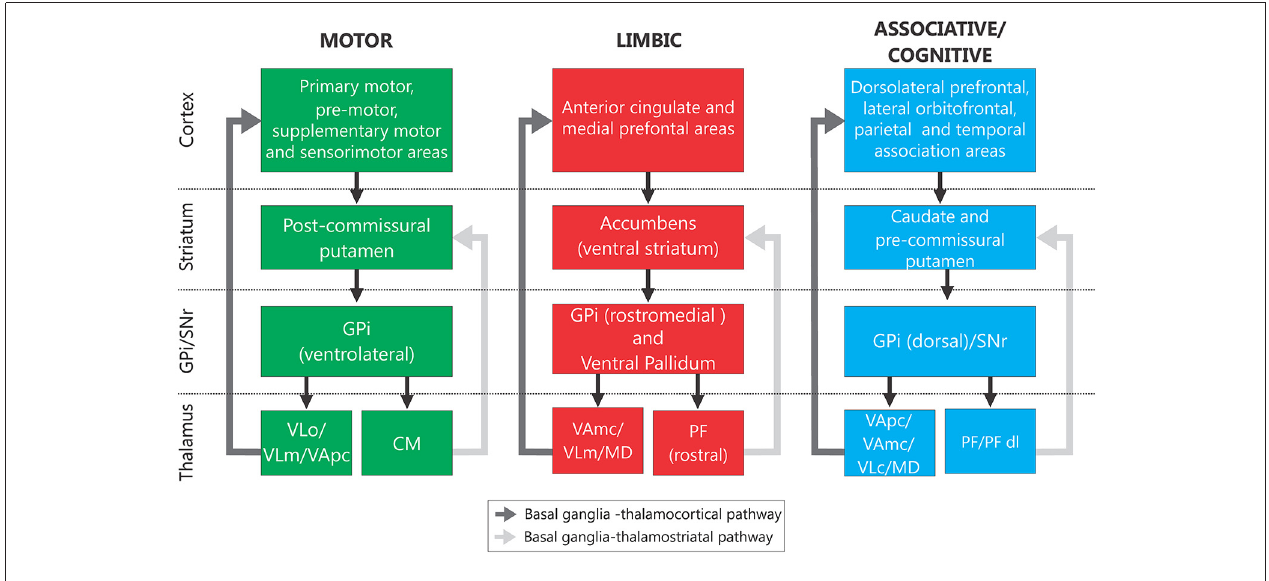
MD, mediodorsal nucleus; PFdl, dorsolateral extension of the PF; VAmc, part magnocellular of VA; VApc, part parvocellular of VA; VLc, caudal part of VL; VLd, dorsal VL; VLo, pars oralis of VL; VLm, medial part of VL (based on Alexander et al., 1986, 1990; Middleton and Strick,